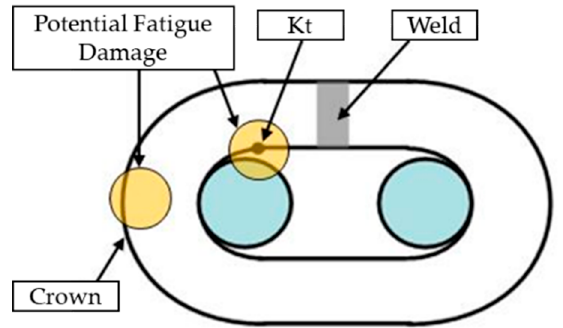
Figure 2. Chain link potential failure locations.